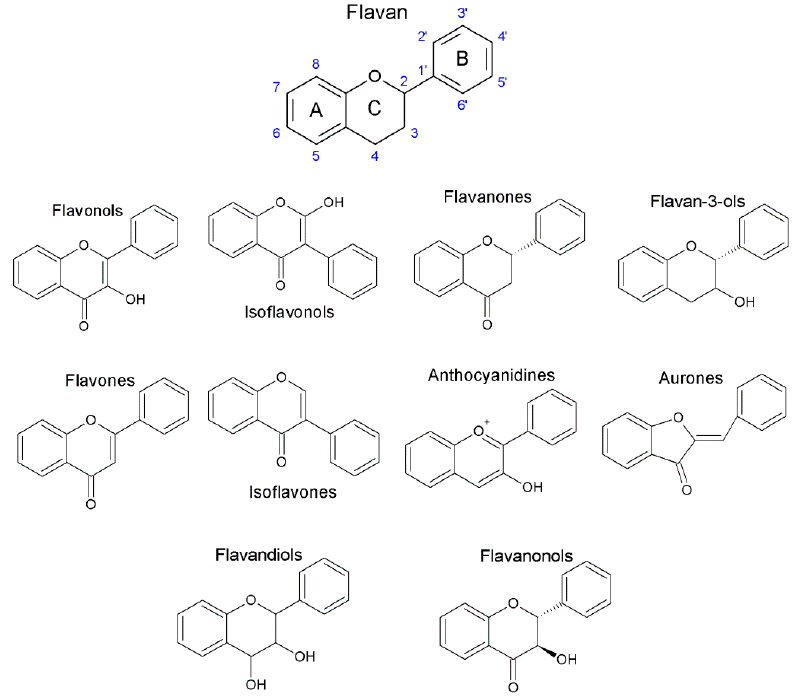
Figure 5. Basic flavonoid structure (flavan) and main classification of flavonoids.